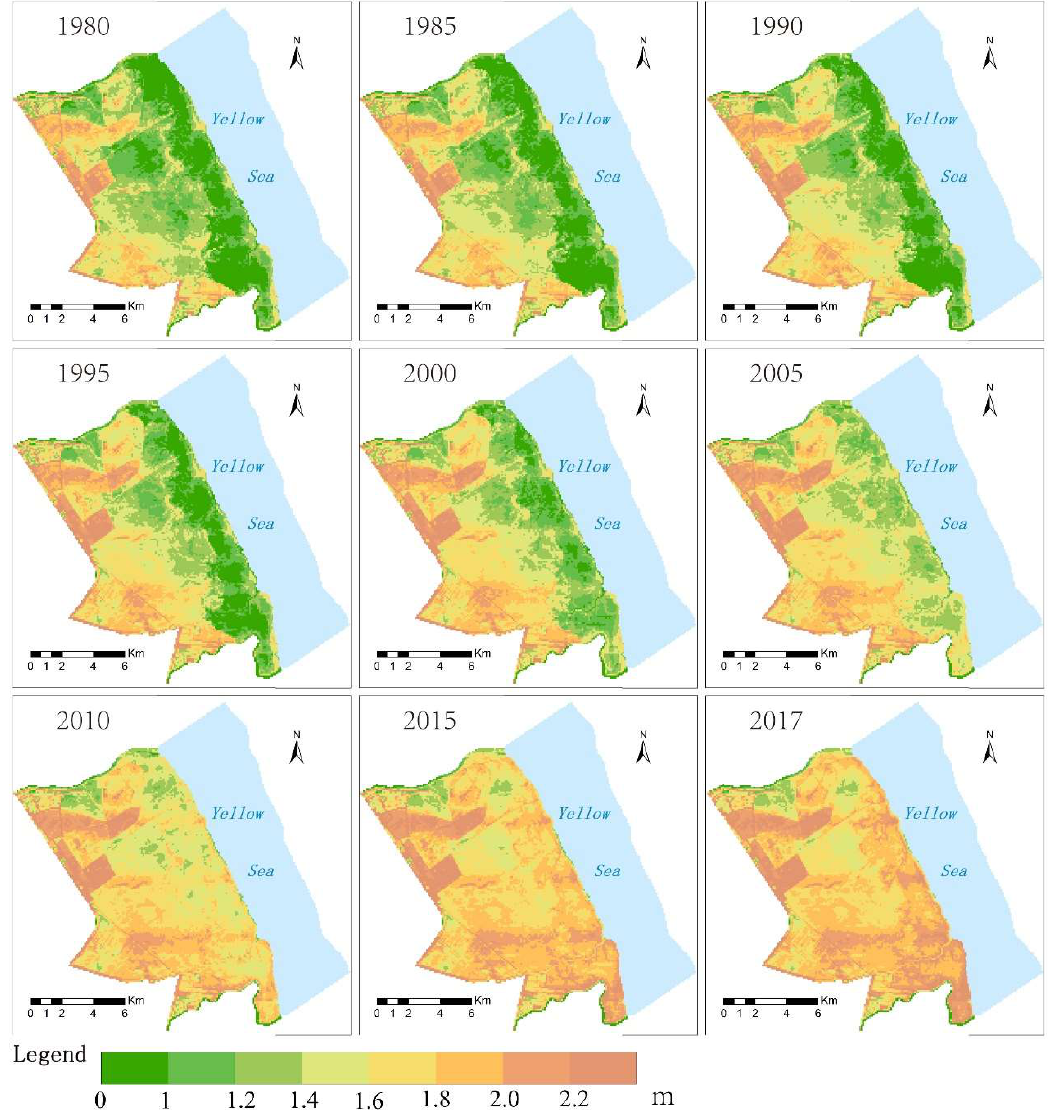
Figure 7. Topographic elevation distribution map of intertidal wetland (1980–2017).